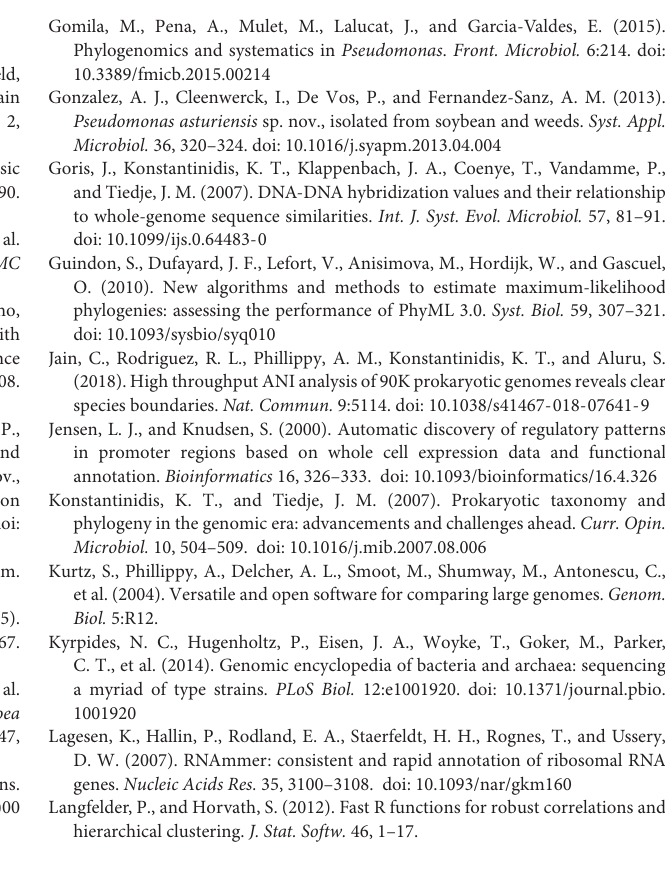
TABLE S2 | Proposed species-level taxonomic affiliations based on 16S rRNA, leu S, concatenated MLSA and whole genome analyses of genome sequences previously reported as Pantoea